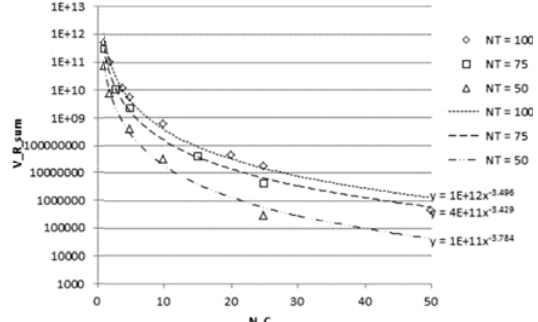
Fig. 4. Po number o transforma